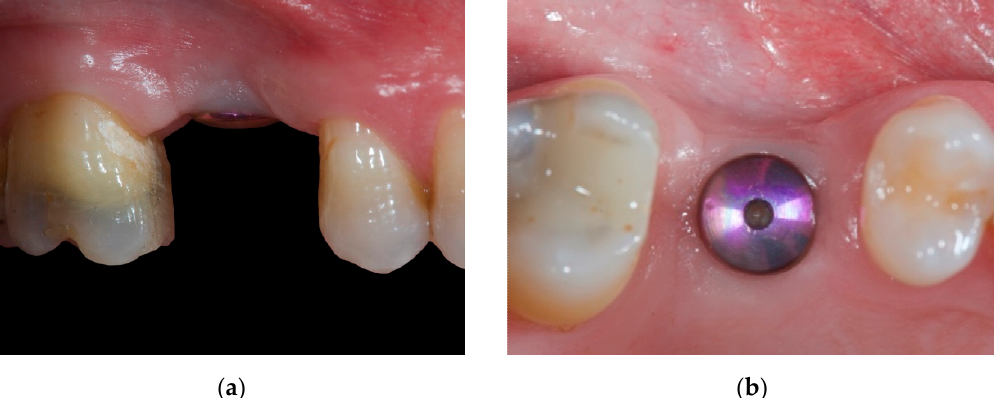
Figure 1. Intraoral view of the soft tissues after a 3-week healing period from the uncovering procedure: ( a ) Lateral view. ( b ) Occlusal view.